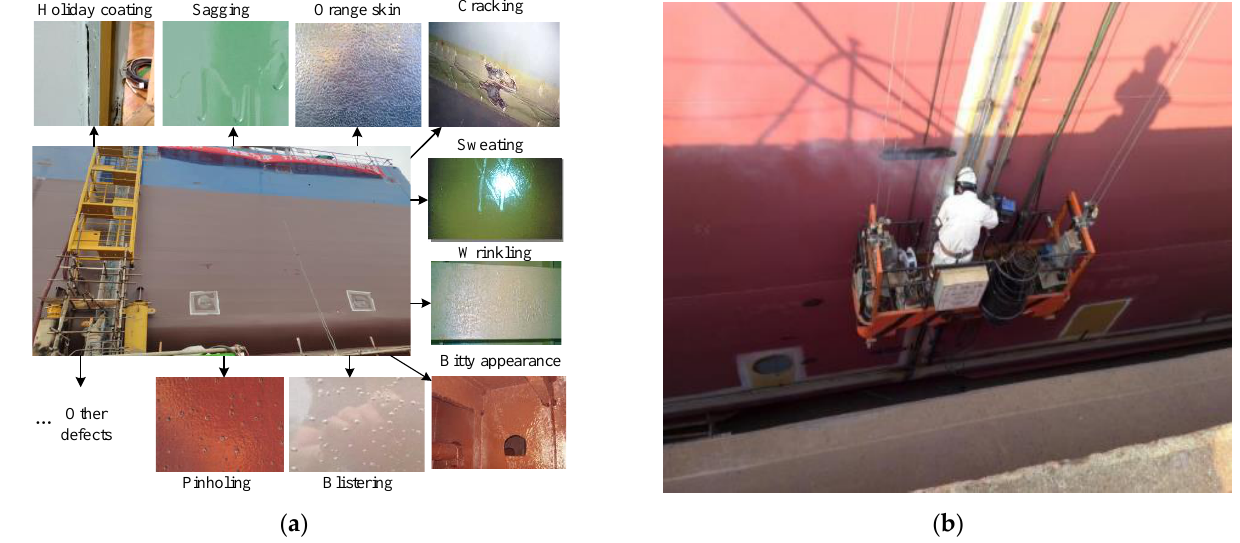
Figure 1. Ship painting operation site: ( a ) Painting defects site; ( b ) Painting and repairing site.